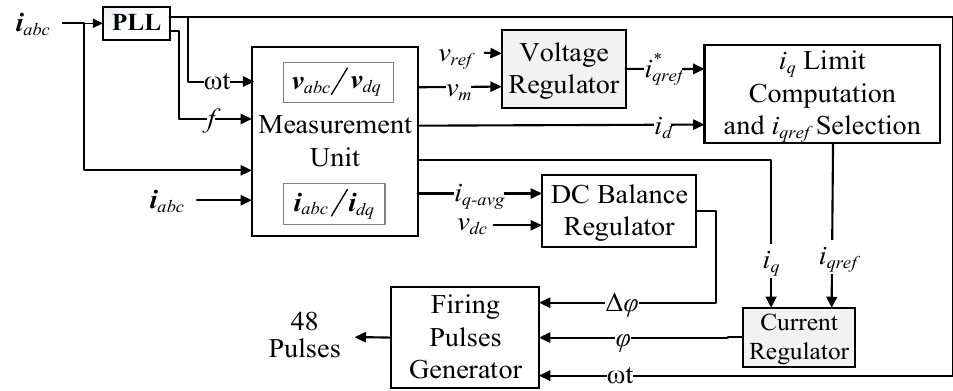
Figure 2. Control block diagram of STATCOM.